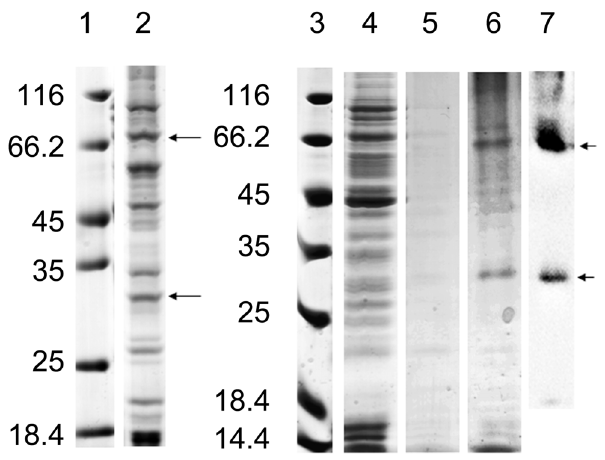
Figure 3. Purification of D-CF produced mAQP4 M23 in 0.2% Brij-35 by Co 2 + -NTA chromatography. Samples were separated by 12% (lanes 1–2) or 16% (lanes 3–7) SDS-PAGE and analysed by Coomassie staining. Lanes 1 and 3, protein marker; Lane 2, precipitate after P-CF expression; Lane 4, flow through; Lane 5, washing fraction; Lane 6, elution fraction; Lane 7, immunoblot of lane 6 using anti-His antibodies. Samples of 2 m l were applied to each lane.